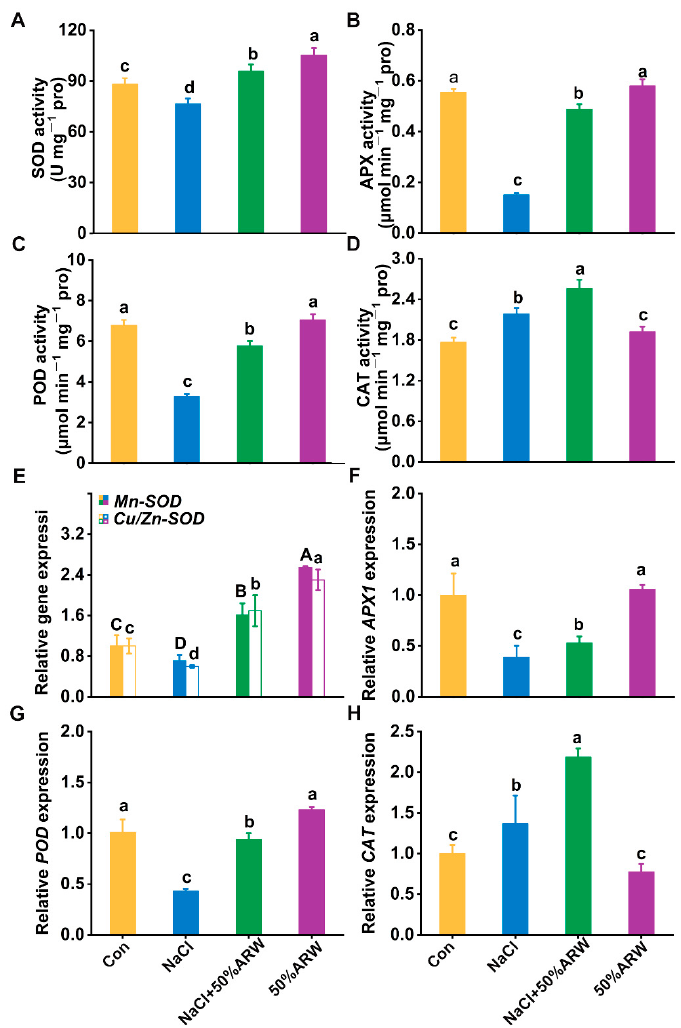
Figure 5. Changes in H 2 O 2 -related antioxidant enzyme activities and transcripts in alfalfa plants. After germination for 3 d, the activities of SOD ( A ), APX ( B ), POD ( C ), and CAT ( D ) were determined. Transcripts of Mn-SOD/Cu/Zn-SOD ( E ), APX1 ( F ), POD ( G ), and CAT ( H ) were analyzed by qPCR. The error bars represent the SD. Bars with different letters were significantly different at p < 0.05 according to Duncan’s multiple range